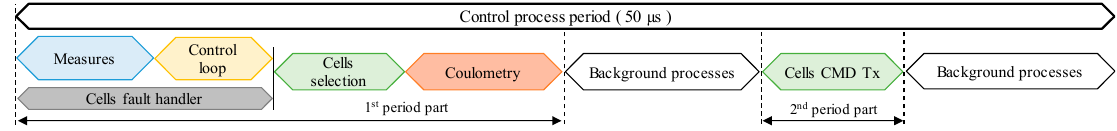
Figure 5. Schedule of a period of the HF SRB control algorithm performed in the master controller.